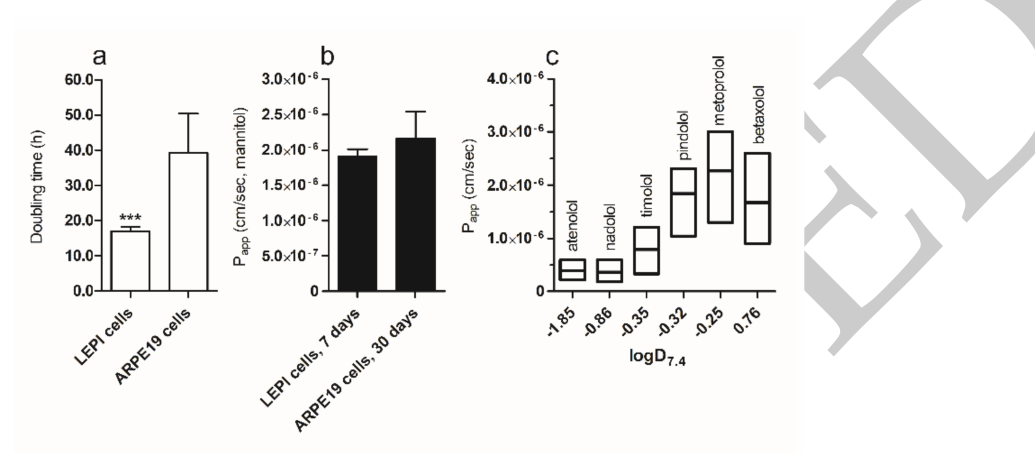
Figure 5. Doubling time and barrier formation of LEPI cells is faster than regular ARPE19 cells. ( a ) Comparison between LEPI and ARPE19 cells shows that cell division rate of LEPI cells is 2.3 times faster than that of regular ARPE19 cells ( n = 12, *** p < 0.0001, determined with unpaired t -test with Welch’s correction). The results are presented as the mean doubling-time ± standard deviation (SD) from four independent cultures, each performed in triplicate. ( b ) LEPI cells ( n = 7) form a barrier against paracellular permeation similar to ARPE19 cells ( n = 5). The apparent permeability coe ffi cient (P app ) of mannitol was similar in LEPI cells after culture of 7 days and in ARPE19 cells that were cultured for 30 days. The bars display average values and error bar standard deviation (SD). ( c ) The permeation of beta-blockers across the tight LEPI monolayers (cultured for 30 days) is related to compound lipophilicity. The apparent permeability coe ffi cients (P app ) are displayed as a range, and the lines represent the average values ( n =